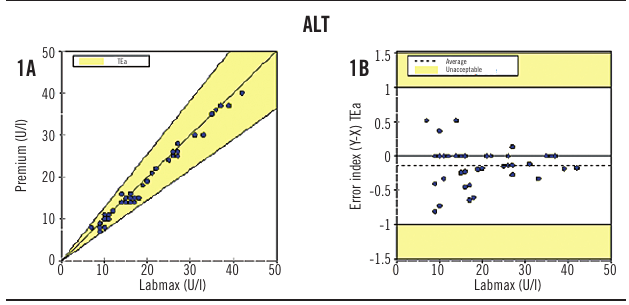
figurE 3 − Comparisons between LDH measurement for automated chemistry platforms A) linear regression for LDH measurements between instruments Labmax 240 ® (E1) and Labmax 240 Premium ® (E2): n = 40, r = 0.983, p < 0.05; equation for the correlation: E2 = 0.902*E1 + 4.6; TEa = 11.4%; B) graph comparing the systems Labmax 240 ® (E1) and Labmax 240 Premium ® (E2) for LDH measurement: error index = [(result - mean)/TEa]